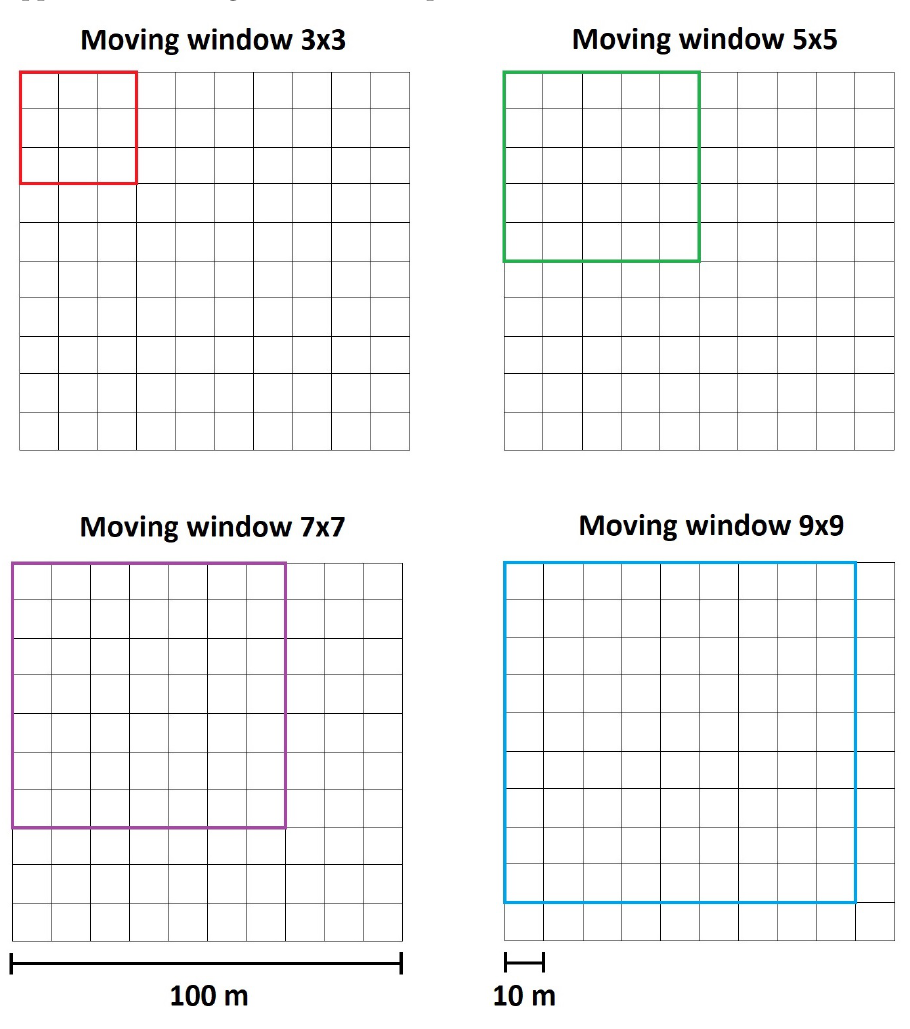
Figure A2. Representation of moving windows (3 × 3, 5 × 5, 7 × 7, 9 × 9) applied to 10 m of spatial